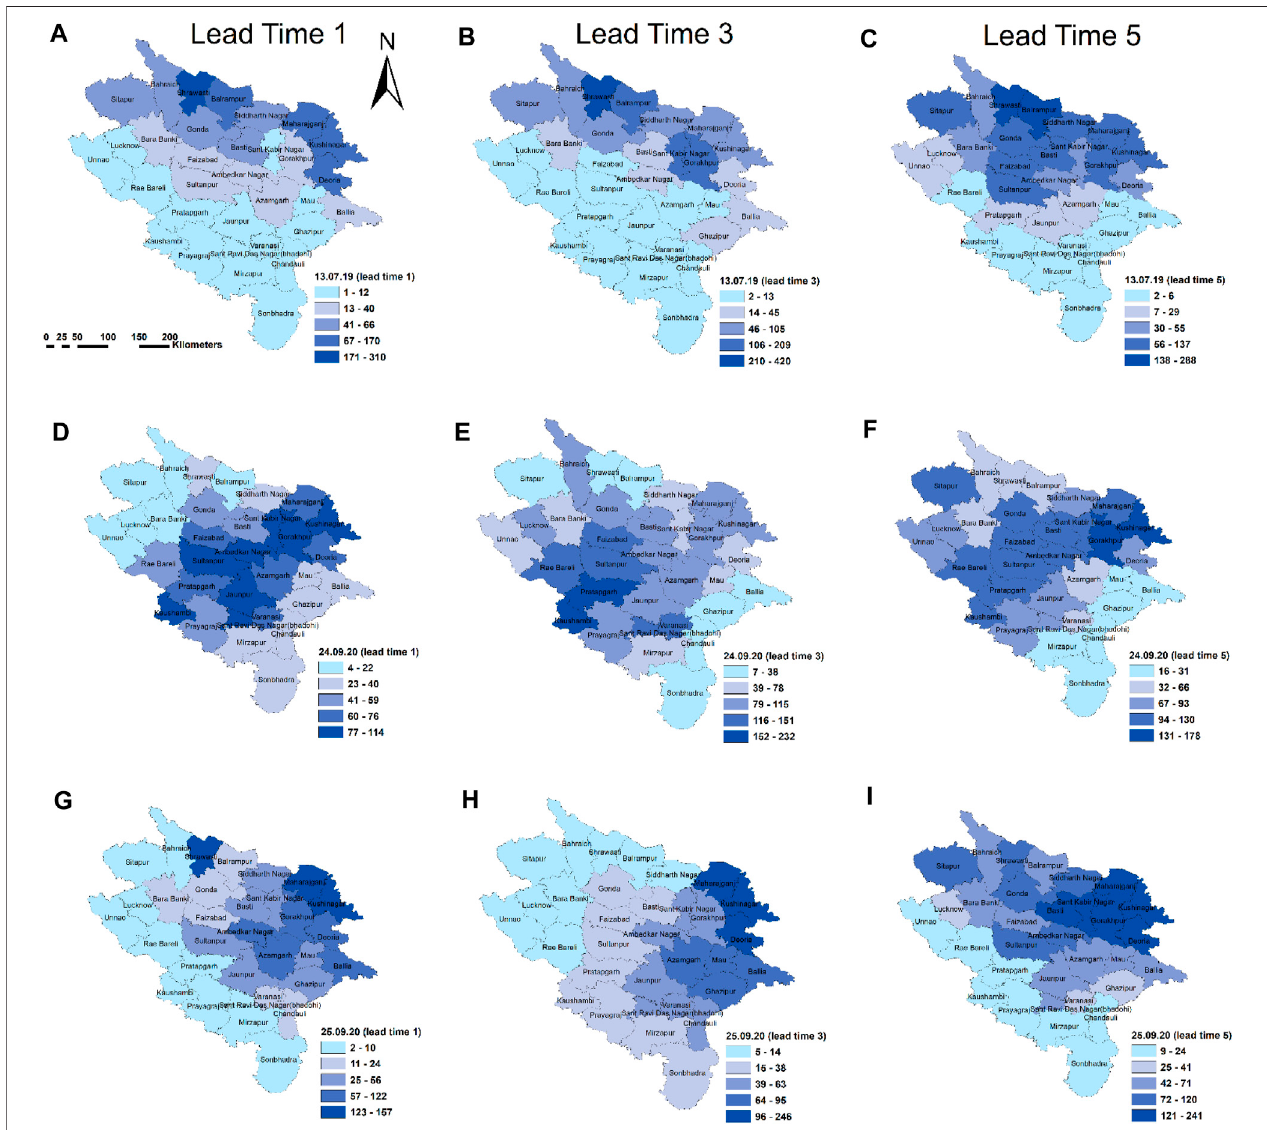
FIGURE 6 | Maps showing the spatial distribution of rainfall for three selected days. Panels (A – C) shows the distribution on 13th July 2019, Panels (D – F) on 24th September 2020 and Panels (G – I) on 25th September 2020 for each of the three lead times, respectively.